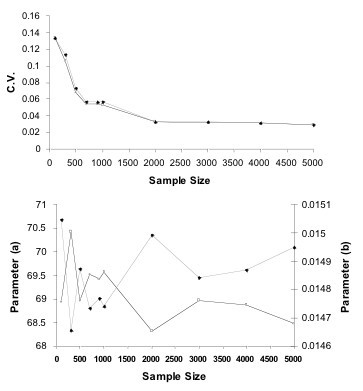
Estimation of gamma function parameters for the error probability distribution of gene TOP2A, with the TN data set. (Bottom) The mean a and b parameters (solid line with white squares and grey line with black diamonds, respectively) estimated for increasing sample sizes uniformly drawn from the space of all possible rule sets. (Top) Coefficients of variation (standard deviation divided by mean) versus sample size (based on 10 samplings).